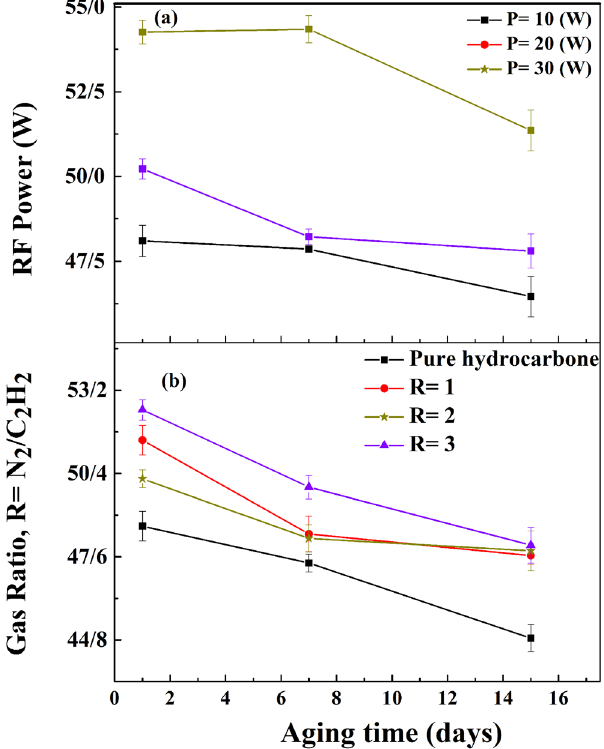
Figure 7. Time evolution of the SFE depending on ( a ) RF power in 20 (w) and ( b ) gas ratio in R = 1.